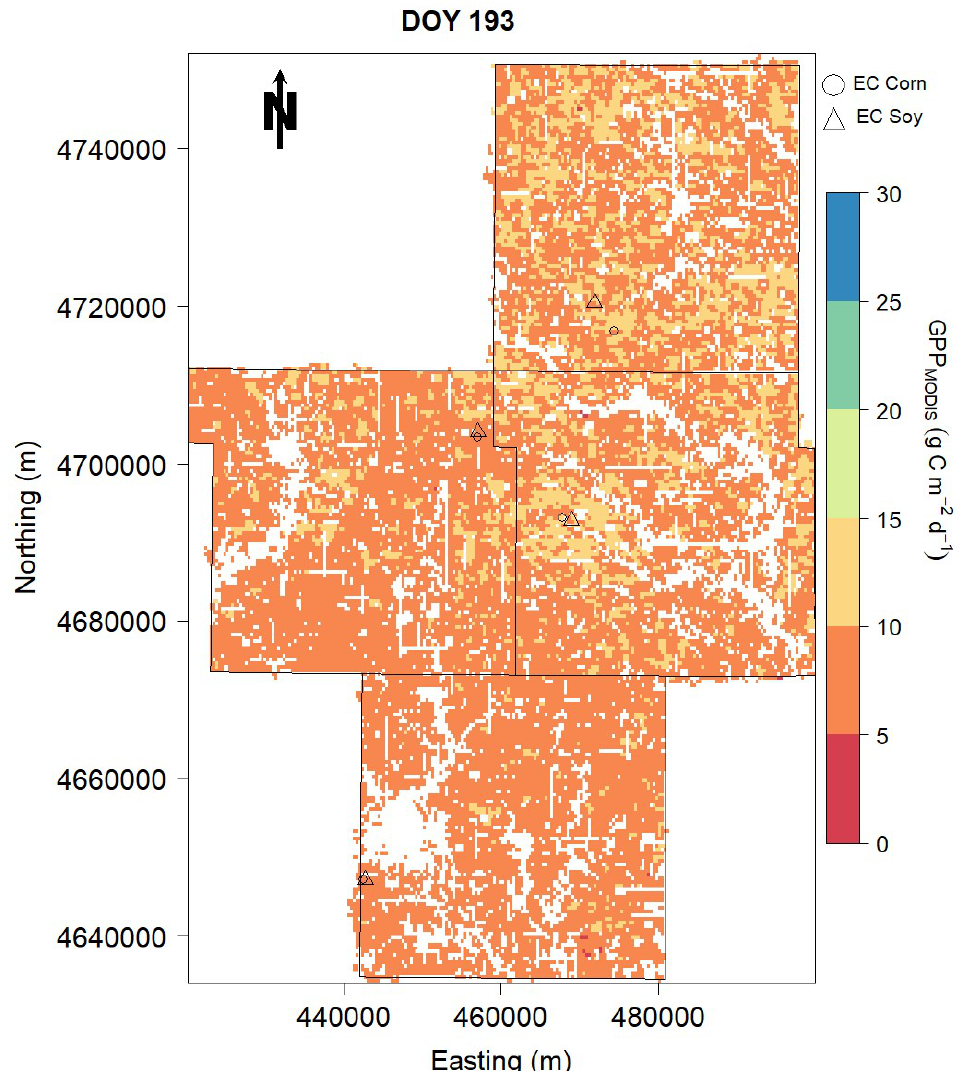
Figure A3. Daily GPP MODIS product (g C m − 2 d − 1 ) on DOY 193 in 2016 for four Iowa counties. Triangles and circles show the location of the eddy covariance (EC) stations in soybean and corn fields, respectively.